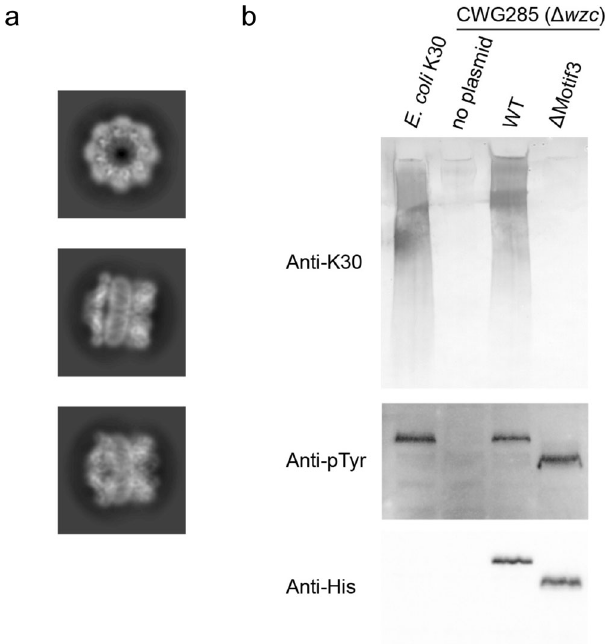
Fig. 5 Function of Wzc periplasm motif 3. a Representative 2D class averages of Wzc K540M Δ Motif3 show the protein forms an octamer. Cryo- EM data were collected on Glacios (Thermo Fisher). Box size, 248 Å. b Western immunoblot of whole cell lysates probed with anti-K30 antiserum to detect cell surface polysaccharides (top panel), the anti-pTyr antibody for pTyr (middle panel) and anti-His 5 antibody for expression (bottom panel). Bacteria were grown for 16 h without L-arabinose induction to achieve amounts of Wzc similar to those from chromosomal copies. Uncropped gels with molecular weight markers are shown in Supplementary Fig. 10b. Experiments were performed in biological triplicate and were consistent, a representative experiment is